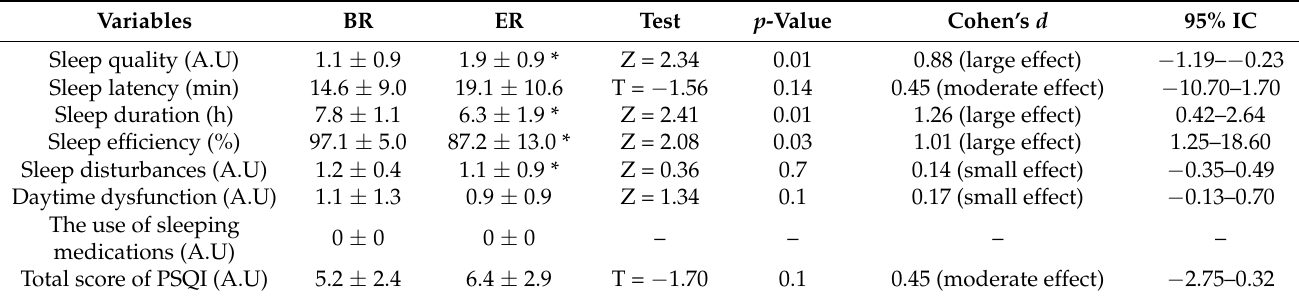
Table 2. Sleep parameters recorded by the PSQI questionnaire before Ramadan (BR) and at the end of Ramadan (ER).